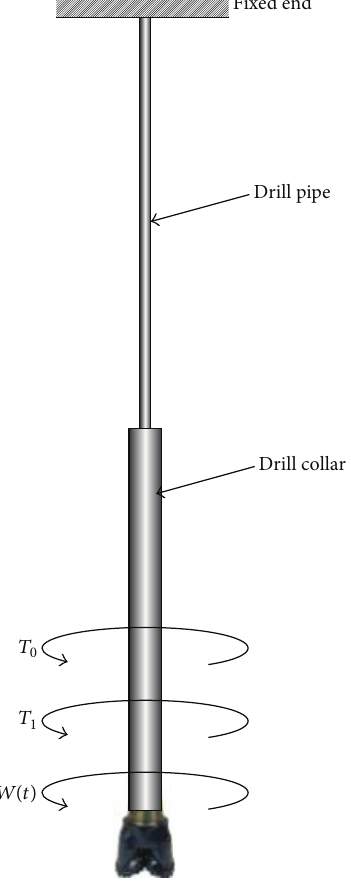
Figure 1: The dynamic model of the